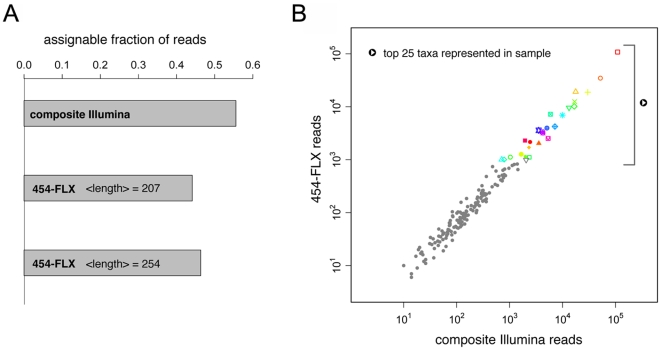
Composite Illumina reads constitute a legitimate alternative to pyrosequencing for metagenomics studies.DNA from a marine metagenomics sample was sequenced with our overlapping mate-pair approach. The composite reads were directly compared to 454-FLX sequences from the exact same sample. A) Fraction of reads that could be assigned to a taxon using the composite reads (mean read length 180 bp), the entire 454-FLX dataset (mean read length 207 bp), or longer 454-FLX reads (mean read length 254 bp). B) Comparison of taxon assignments using composite reads and 454-FLX pyrosequencing reads. The top 25 represented taxa, with colored symbols next to the bracket, are listed in Table S1.